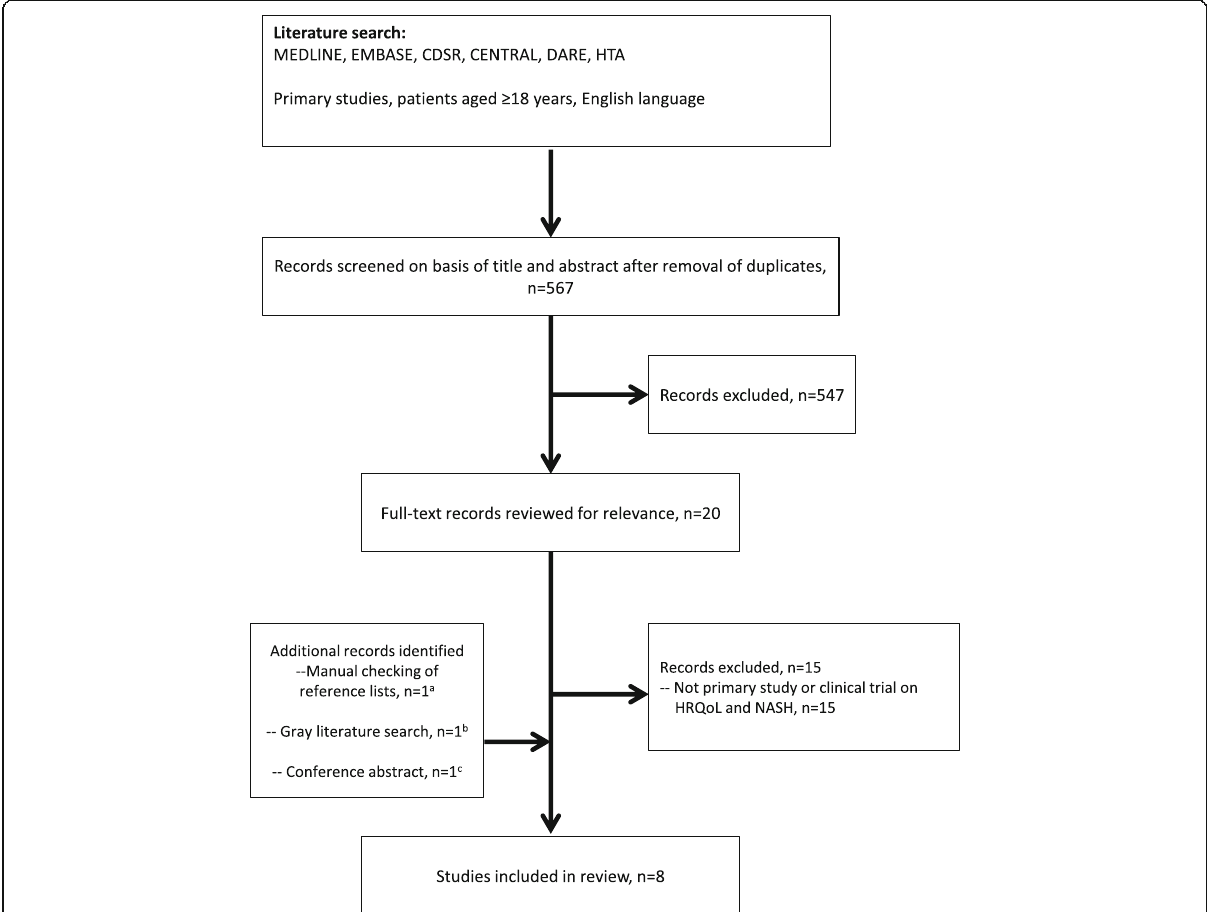
Fig. 1 PRISMA flow diagram of search results. a Sanyal et al., 2010 [16] (from an excluded paper). b Sayiner et al. 2016 [13] (from gray searches). c Palsgrove et al. 2016 [17] (conference abstract from ISPOR 2016). HRQoL, health-related quality of life; PRISMA, Preferred Reporting Items for Systematic Reviews and